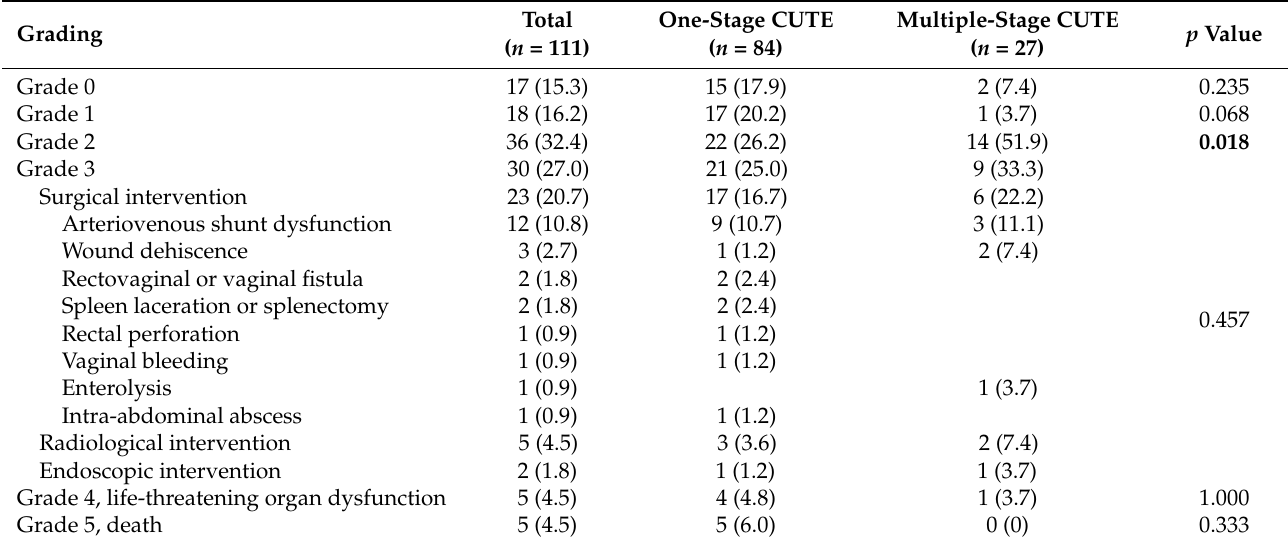
Table 3. Clavien–Dindo grade 0–5 complications after